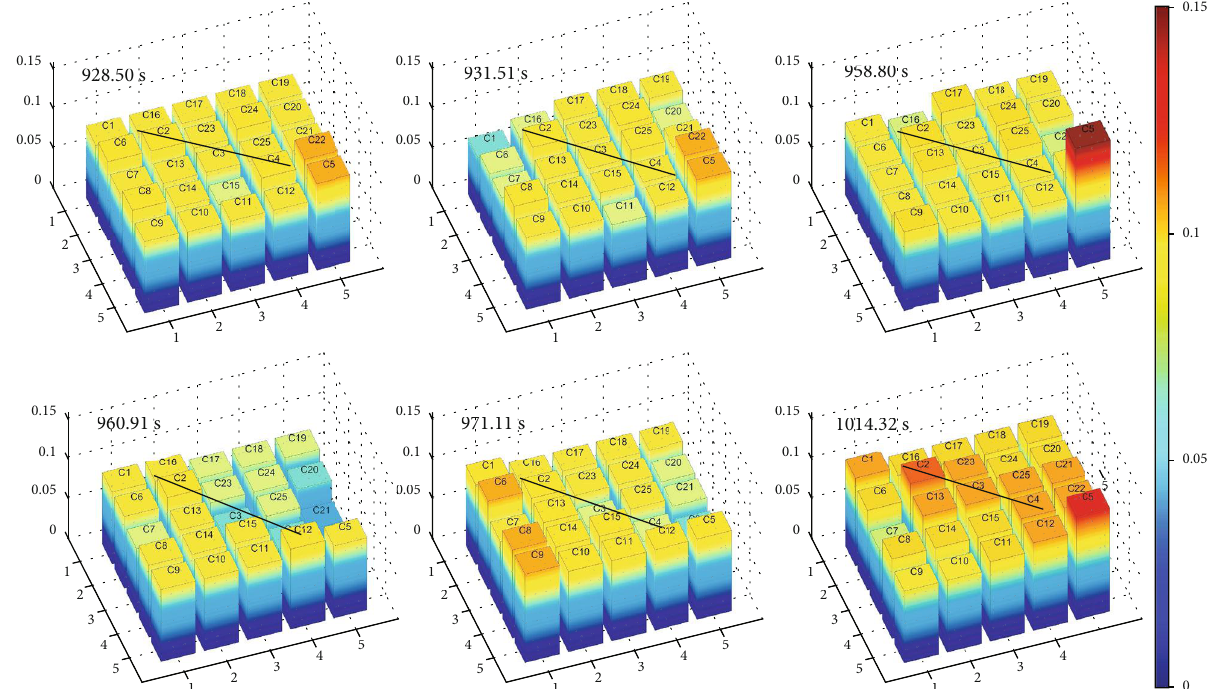
Figure 5: AIRT increment histogram under 14MPa before peak stress (Black line indicates the prefabricated crack), reading from left to right and then up to the bottom.